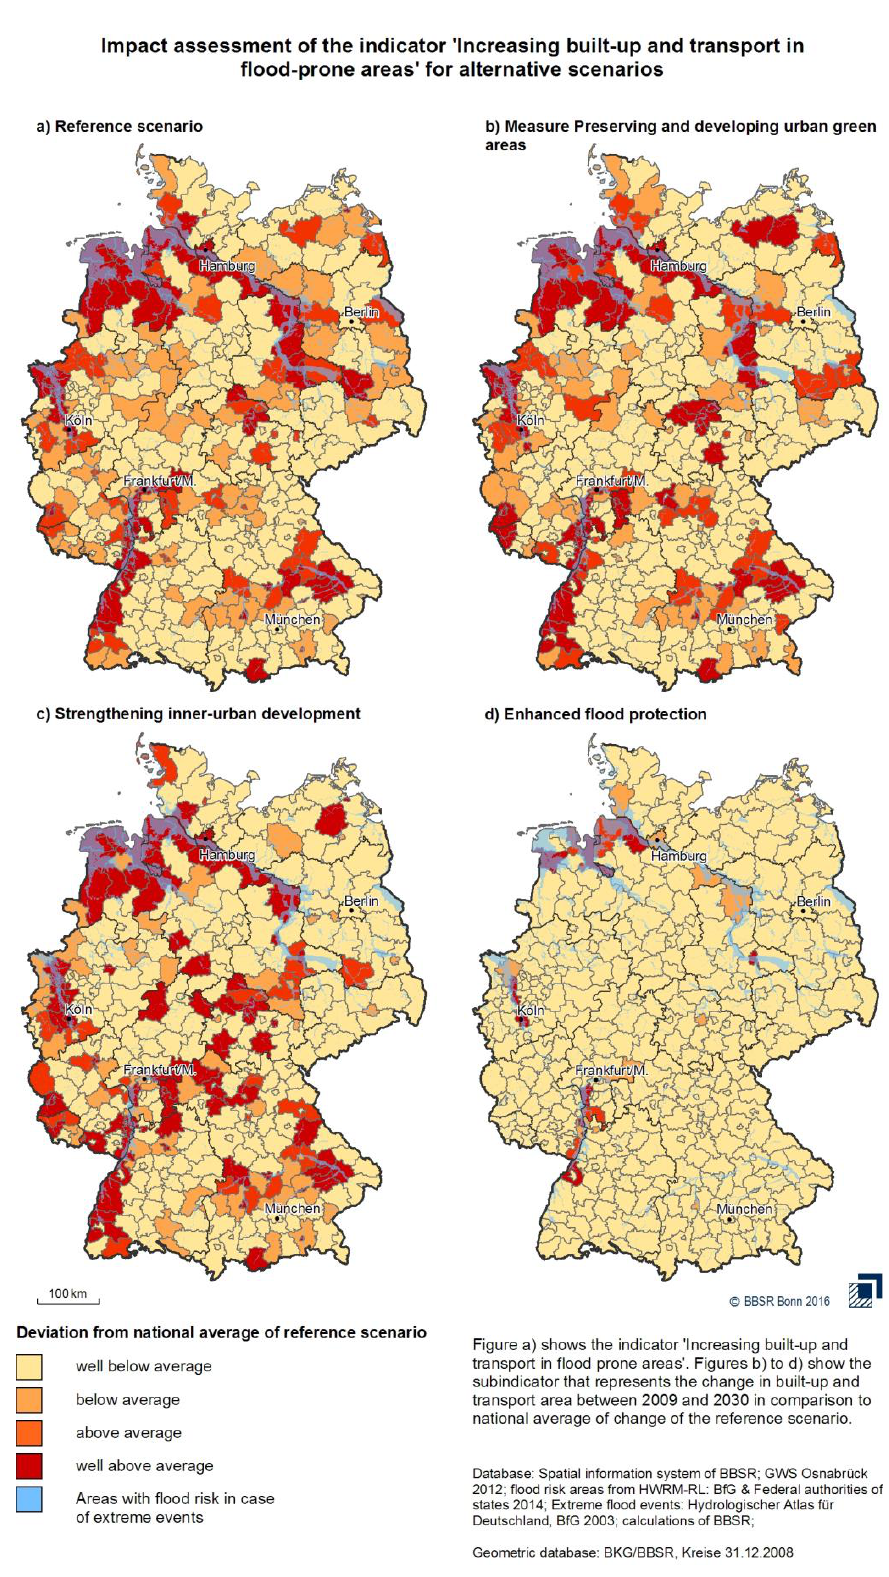
Figure 4. Increasing built-up and transport in flood prone areas. Comparing the ( a ) reference and alternative scenarios with: ( b ) “Preserving and developing urban green areas”; ( c ) “Strengthening inner-urban development”; and ( d ) “Enhanced flood protection”.